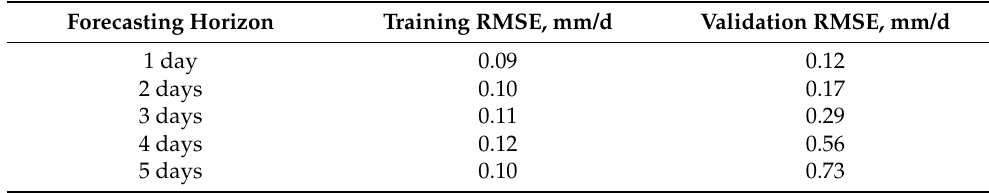
Table 14. Training and validation performances of the developed Bi-LSTM models at Ishurdi station. Forecasting